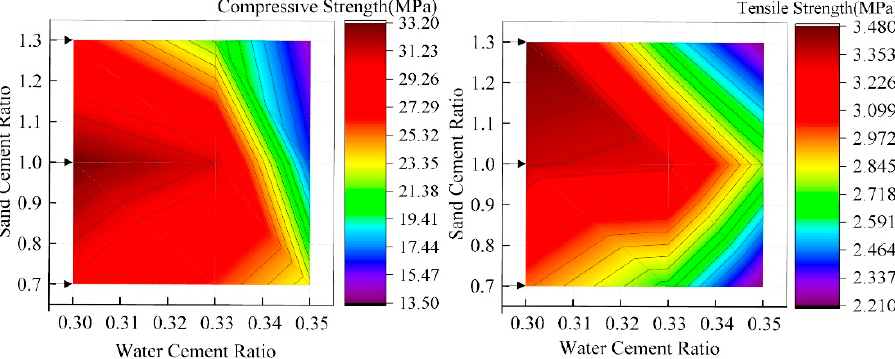
Figure 11. The influence of WCR on compressive strength and tensile strength.